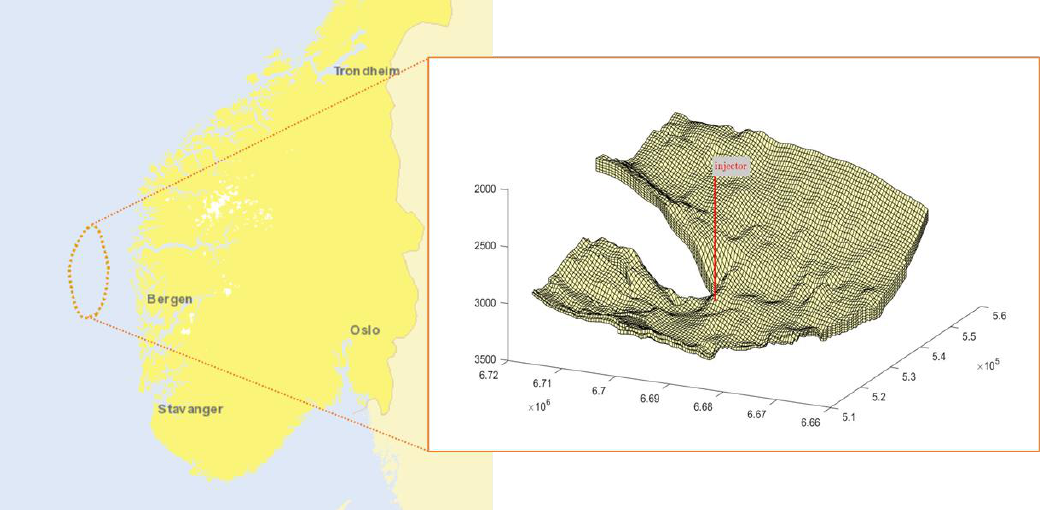
Figure 1. The location and the geological model of the Johansen aquifer with the well location [53].